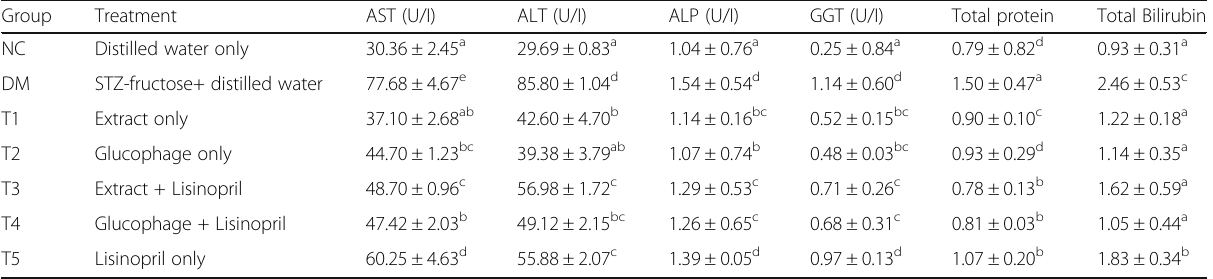
Table 2 Effect of combined administration of lisinopril and ethanolic extract of E. chlorantha on serum biomarkers of liver function Group